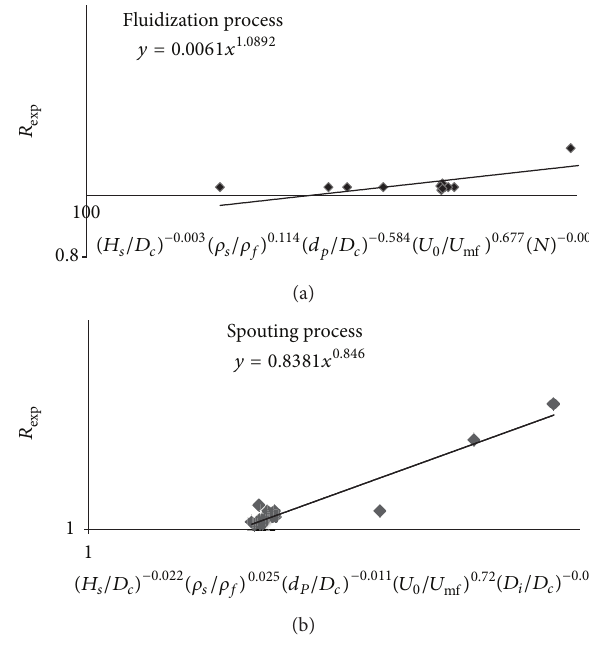
Figure 6: Comparison plot of fluidization index for fine particles.